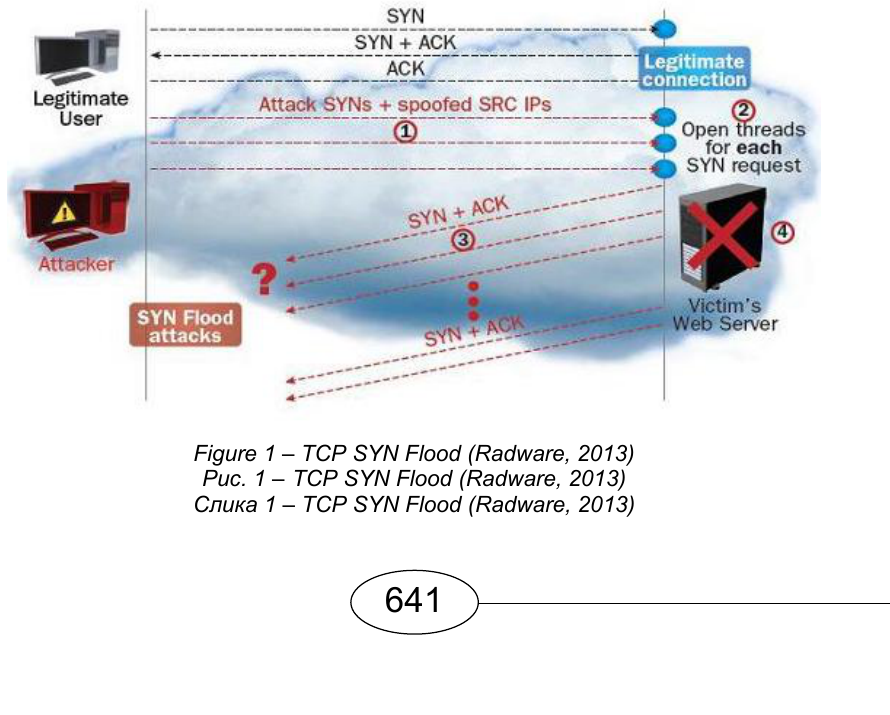
Figure 1 – TCP SYN Flood (Radware, 2013) Рис . 1 – TCP SYN Flood (Radware, 2013) Слика 1 – TCP SYN Flood (Radware,